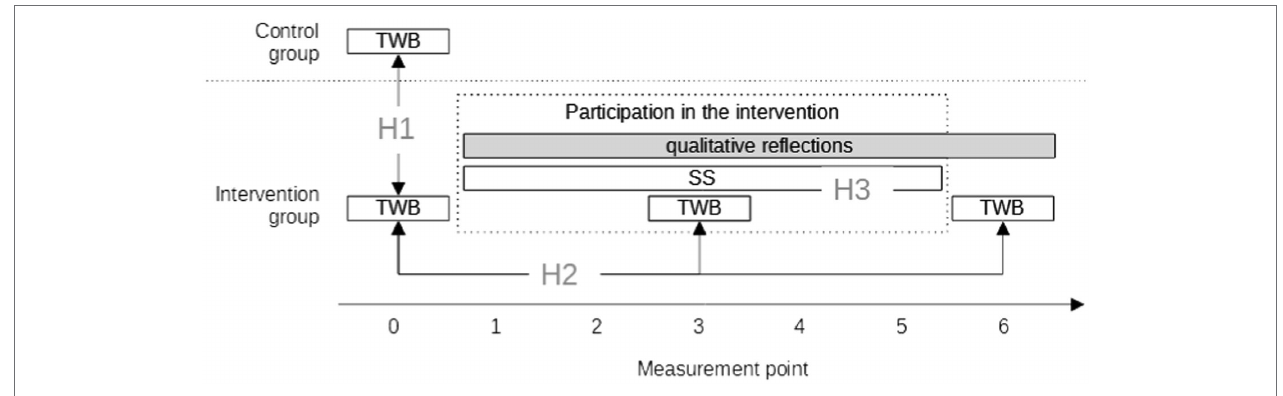
FIGURE 1 | Temporal setup of the study. TWB, Teacher Well-Being; SS, Social Support, and H,